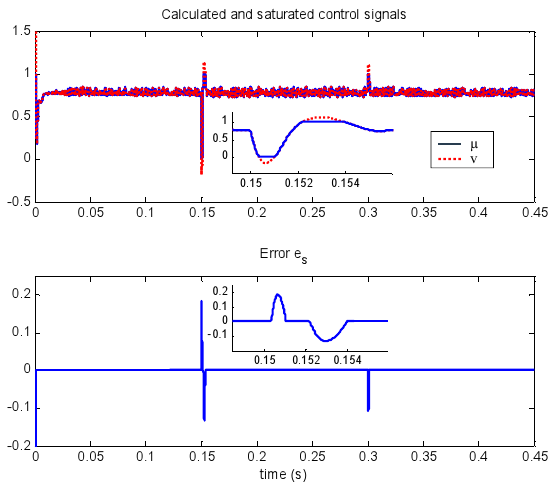
Figure 12. Computed control signal ( t ) , the applied value µ ( t ) , and the error e s ( t ) in the presence of load resitance uncertainty.